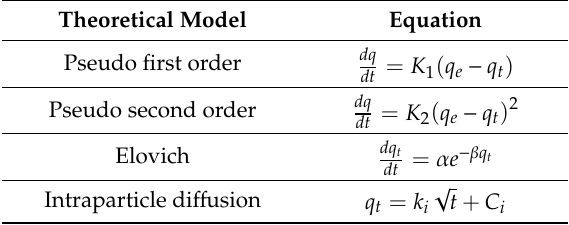
Table 4. Theoretical adsorption models employed for the photodegradation of the CR by Fe 3 O 4 NPs.